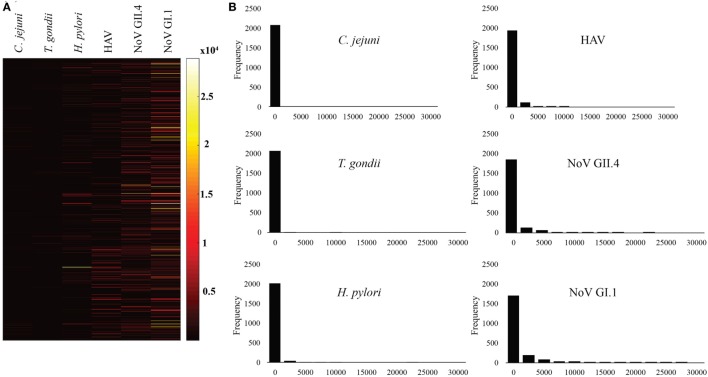
Median fluorescence intensity (MFI) profile of study participants. (A) Heat map visualization of study participants’ antibody profiles to six waterborne pathogens provides insight on possible exposure patterns. Each row presents the MFI values of the target pathogens for the individual saliva sample collected from beachgoers. (B) Histograms showing the non-normal distribution of target pathogen MFIs for the study participants.